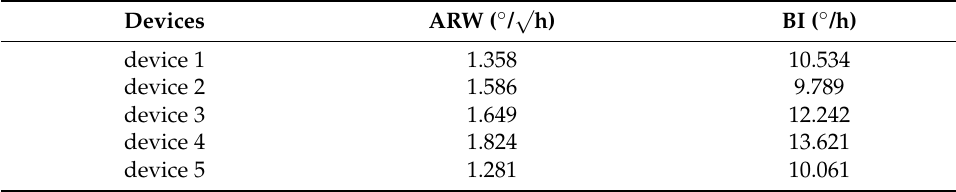
Figure 13. The Allan standard variance analysis results for typical BFVG.